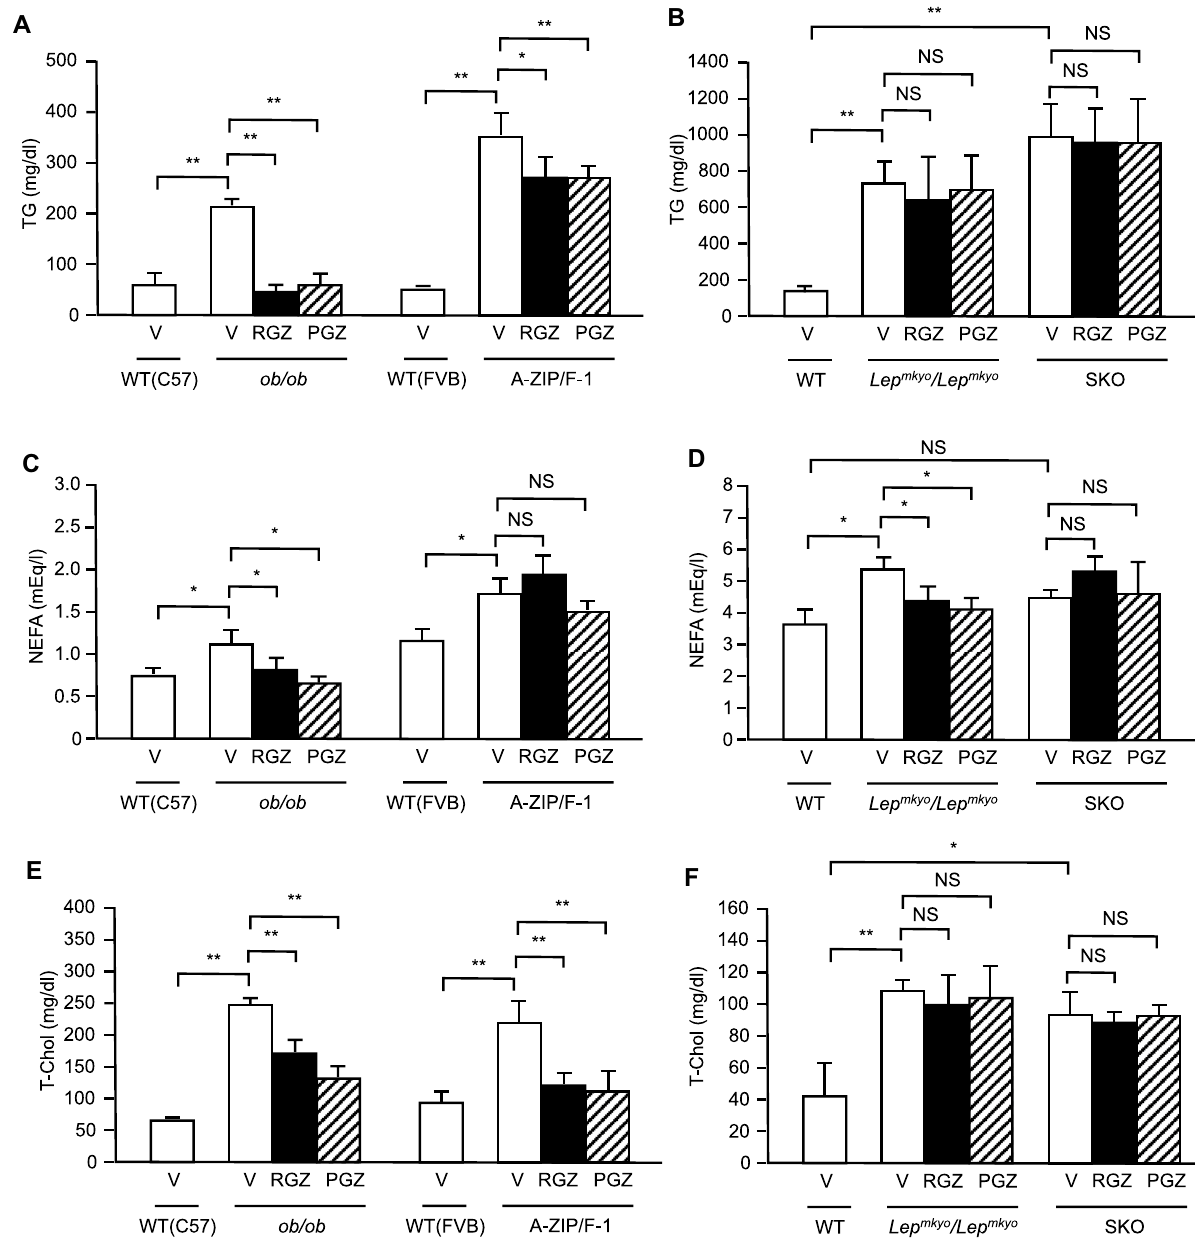
Figure 5. Effect of TZD treatment on lipid metabolism in mouse and rat models of leptin deficient obesity and generalized lipodystrophy. ( A , B ) Plasma triglyceride, ( C , D ) NEFA and ( E , F ) total cholesterol concentrations in C57B/6J WT, ob/ob , FVB/N WT and A-ZIP/F-1 mice ( A , C , E ) and F344 WT, Lep mkyo /Lep mkyo and SKO rats ( B , D , F ) treated with vehicle, RGZ or PGZ. Values are means ± SEM ( n = 10 per group). * P < 0.05, ** P < 0.01, NS, not significant (one-way ANOVA followed by Tukey’s